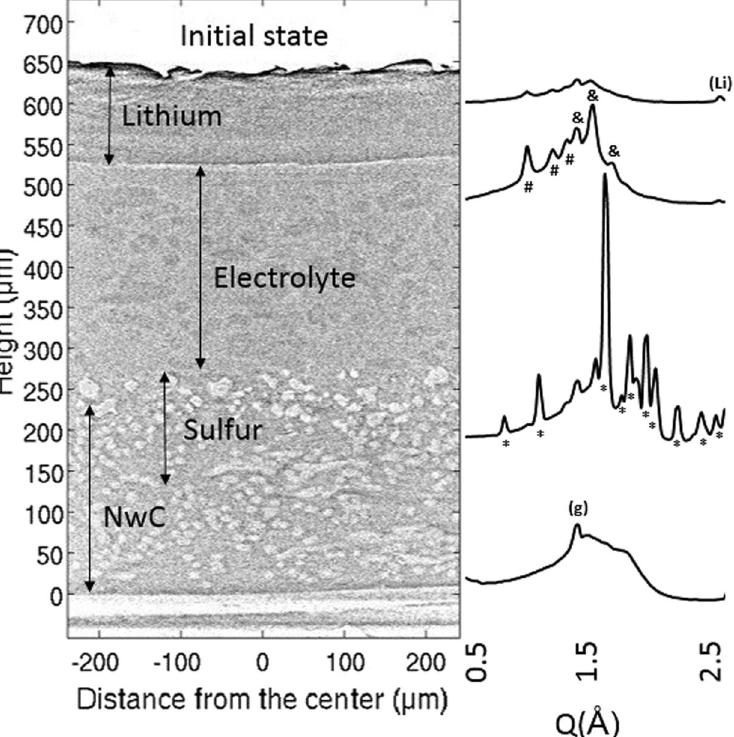
Figure 2. Vertical slice of the tomographic cell at initial state with the associated X-Ray Diffraction (XRD) patterns ((g): graphite// * : sulfur//#: celgard ® //&: viledon ® //(Li): lithium). Light grey corresponds to high absorptive species ( i . e . NwC & sulfur), whereas dark grey corresponds to less absorptive species ( i . e . electrolyte &